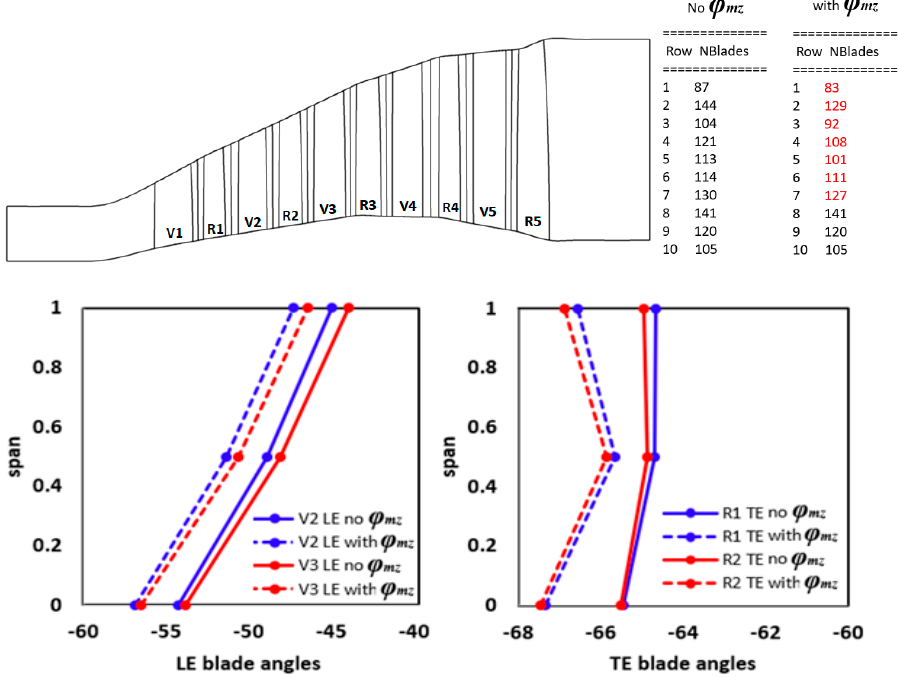
Figure 20. Five ‐ stage E 3 LPT representative configuration showing different blade count and blade angles due to streamline slope being accounted for in a meanline axial turbine design solver.